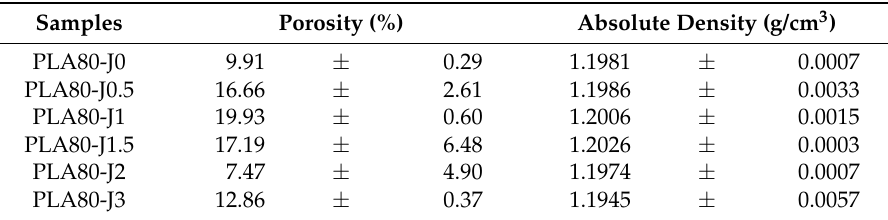
Table 3. Values obtained for porosity and absolute density of FDM printed samples.